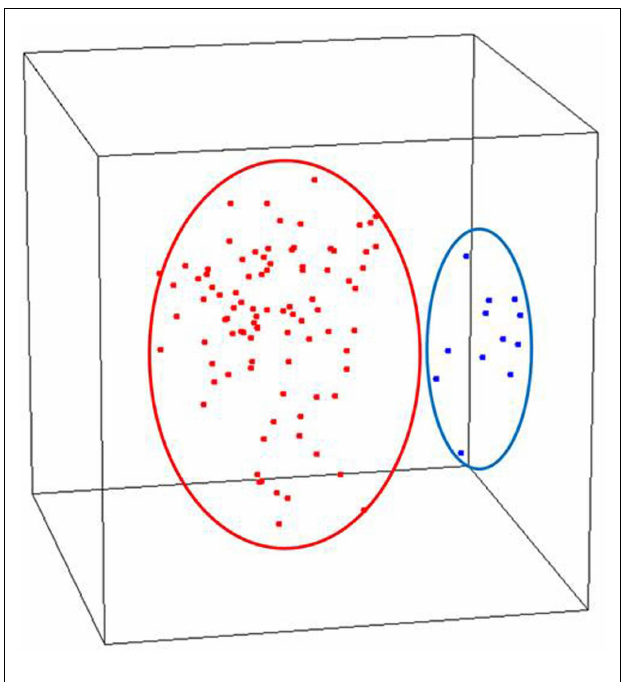
FIGURE 1 | Unsupervised analysis of stage I endometrial cancers versus normal post-menopausal endometrium controls (red, endometrial cancer; blue, normal endometrium controls)